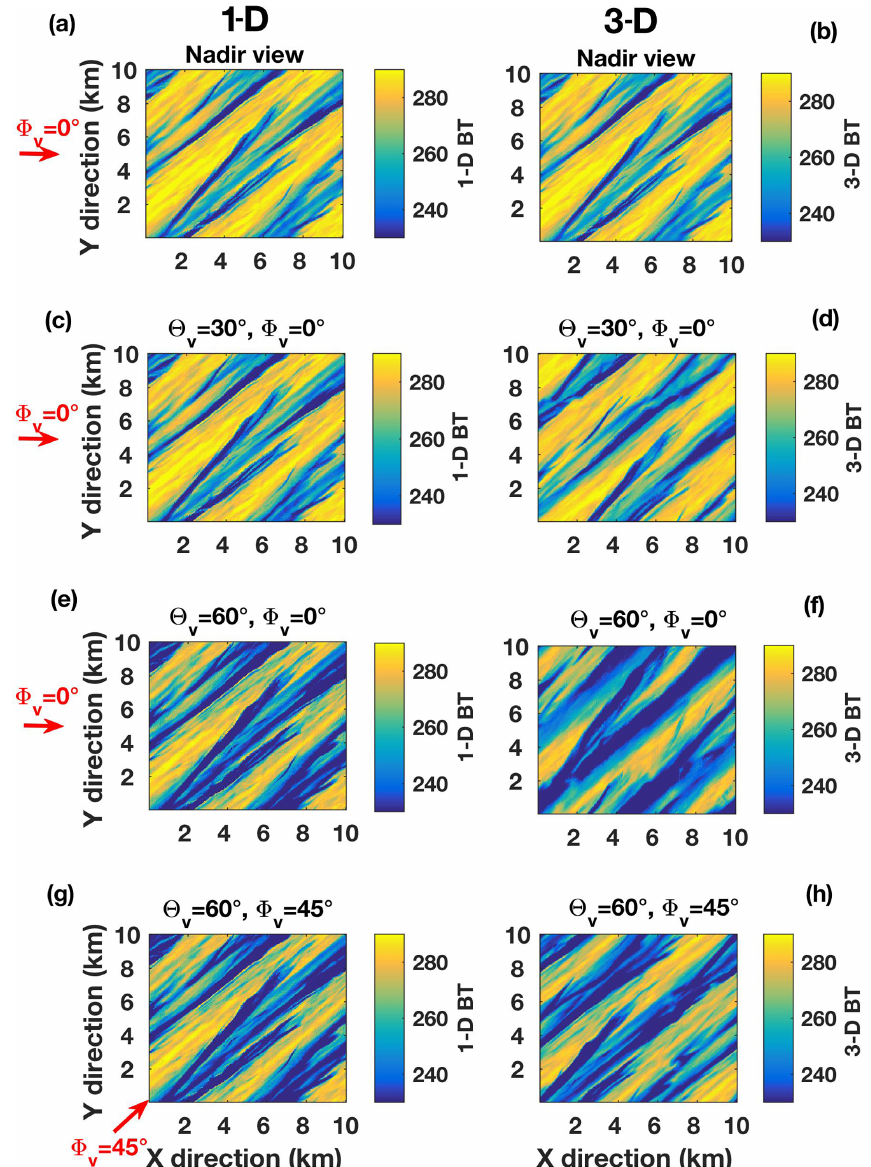
Figure 12. One-dimensional (a, c, e, g) and three-dimensional (b, d, f, h) BT fields at 11 . 01µm and at 50m spatial resolution view at a zenith angle of (cid:50) v = 0, 30 and 60 ◦ , respectively, for an azimuth viewing angle of (cid:56) v = 0 ◦ and (cid:56) v = 45 ◦ represented by the black arrows.